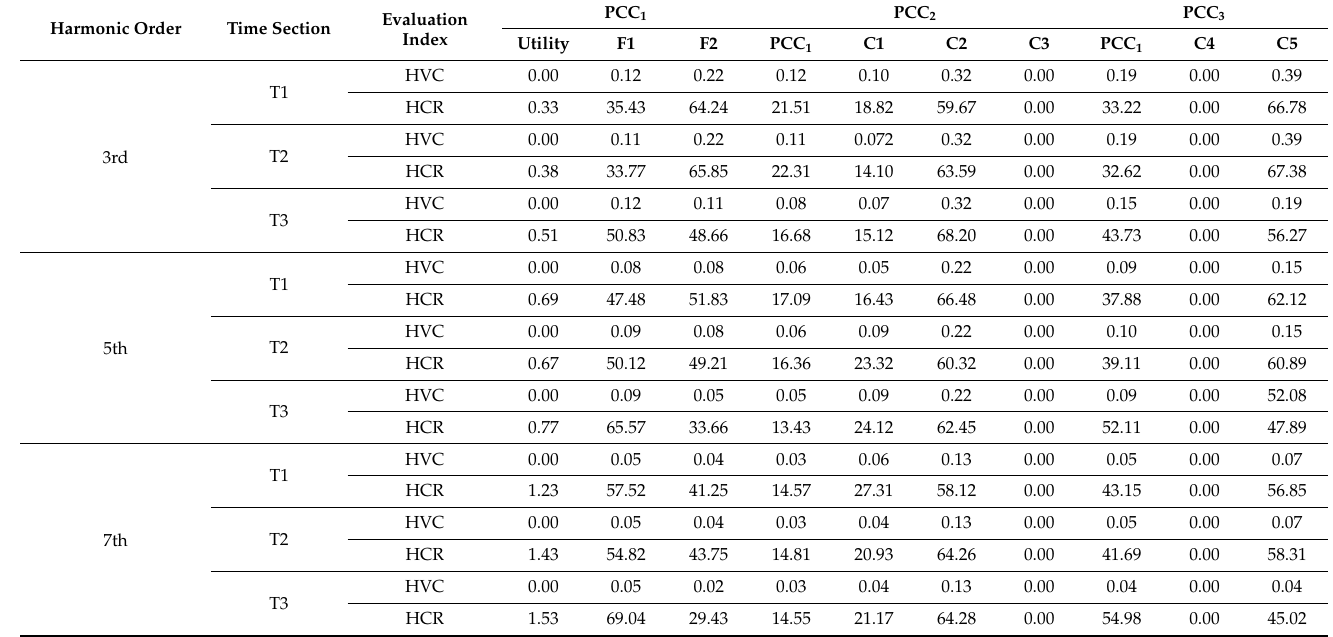
Table 4. The assessment results of HVC and HCR for the 3rd, 5th and 7th orders.